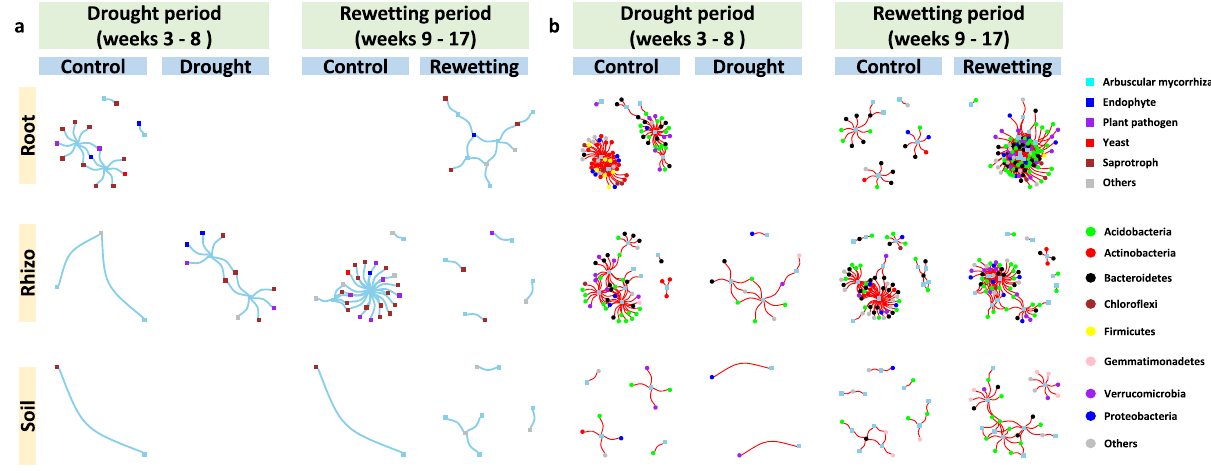
Fig. 5 Network of co-occurrences related to arbuscular mycorrhizal fungi (AMF). a Network of signi fi cant positive co-occurrences between AMFs and other fungi. b Network of signi fi cant positive co-occurrences between AMFs and bacteria. Source data are provided as a Source Data